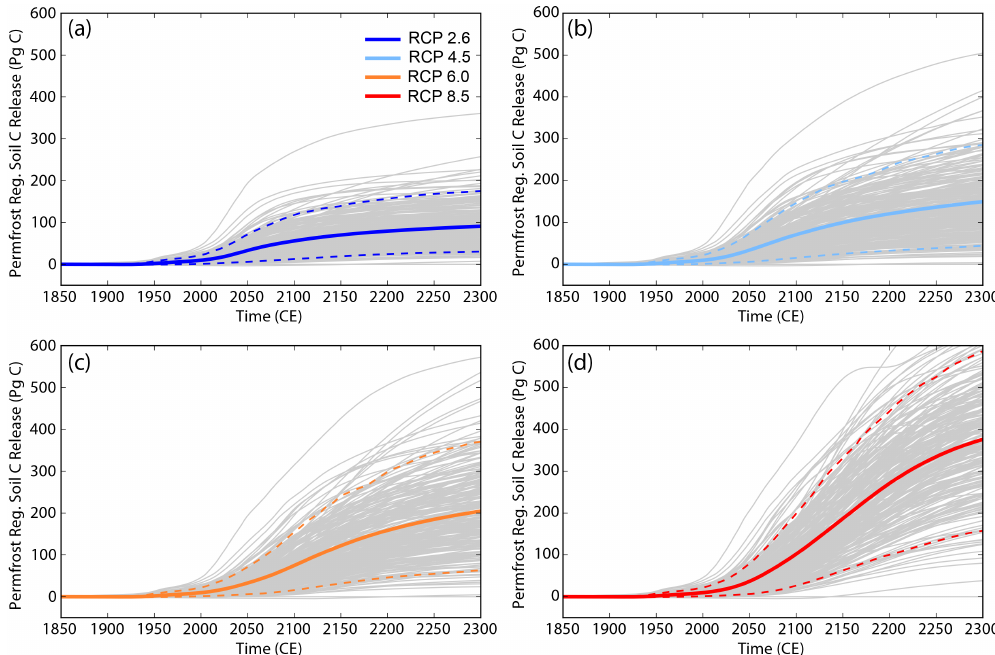
Figure 3. Release of carbon from the permafrost region for all 250 model variants (grey lines) and four RCP scenarios. Mean for each scenario shown with think solid line. Fifth and 95th percentiles shown with dashed lines.